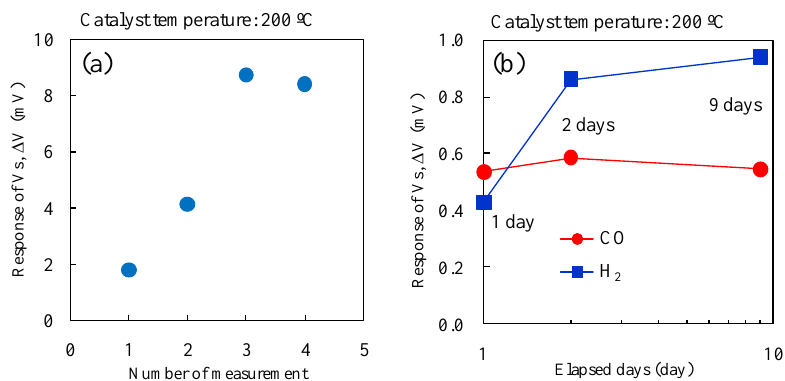
Figure 10. Gas response of the micro-TGS with AuPtPd/SnO 2 catalyst: ( a ) ΔV against time for the micro-TGS with 10,000 ppm H 2 in dry air; and ( b ) long-term stability of ΔV from the micro-TGS with AuPtPd/SnO 2 catalyst for 1000 ppm H 2 in dry air or 1000 ppm CO in dry air at 200 °C for 1–9 days.